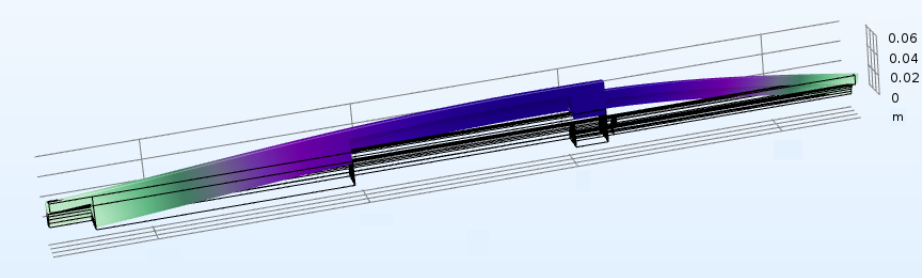
Figure 18. Modal analysis of the simplified actuator